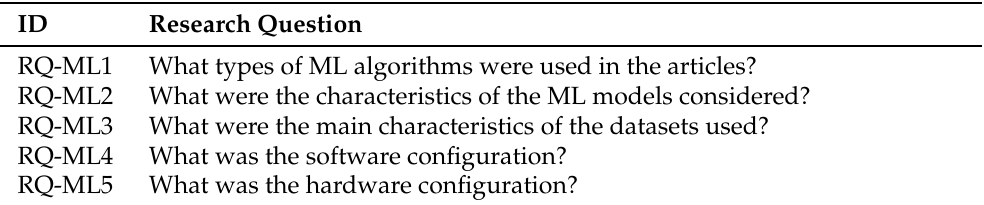
Table 3. Research questions about machine learning .